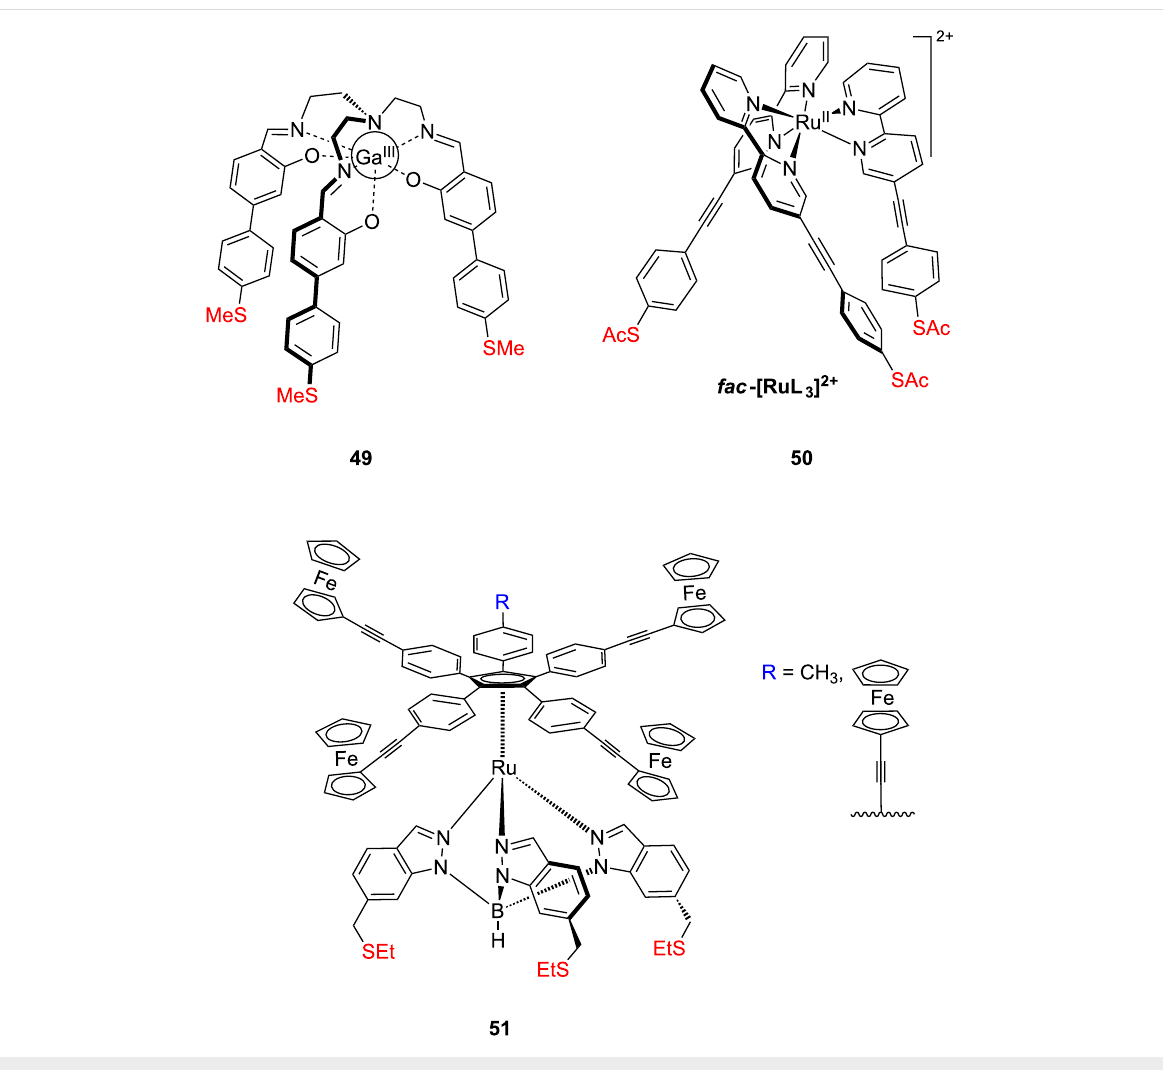
Michl and co-workers described the preparation of a compound whose molecules consist of two cyclobutadienecyclopentadi- enylcobalt sandwich stands carrying ten sulfur-containing “tentacles” with affinity to metal surfaces and holding an axle that carries a dipolar 52 (fluorinated phenanthrene derivative) or a non-polar 53 (pyrene derivative) rotator and served as a dipolar and nonpolar altitudinal molecular rotors (Figure 28) on Au(111)